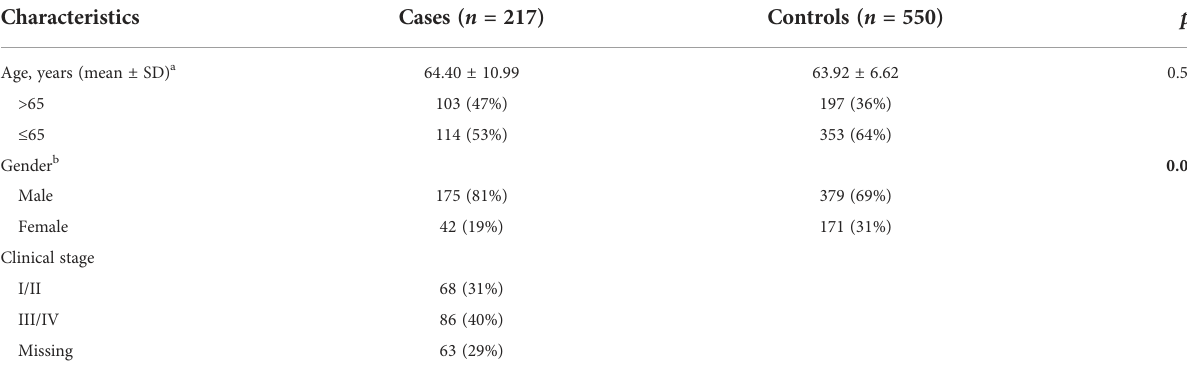
TABLE 2 Characteristics of bladder cancer patients and healthy controls in this